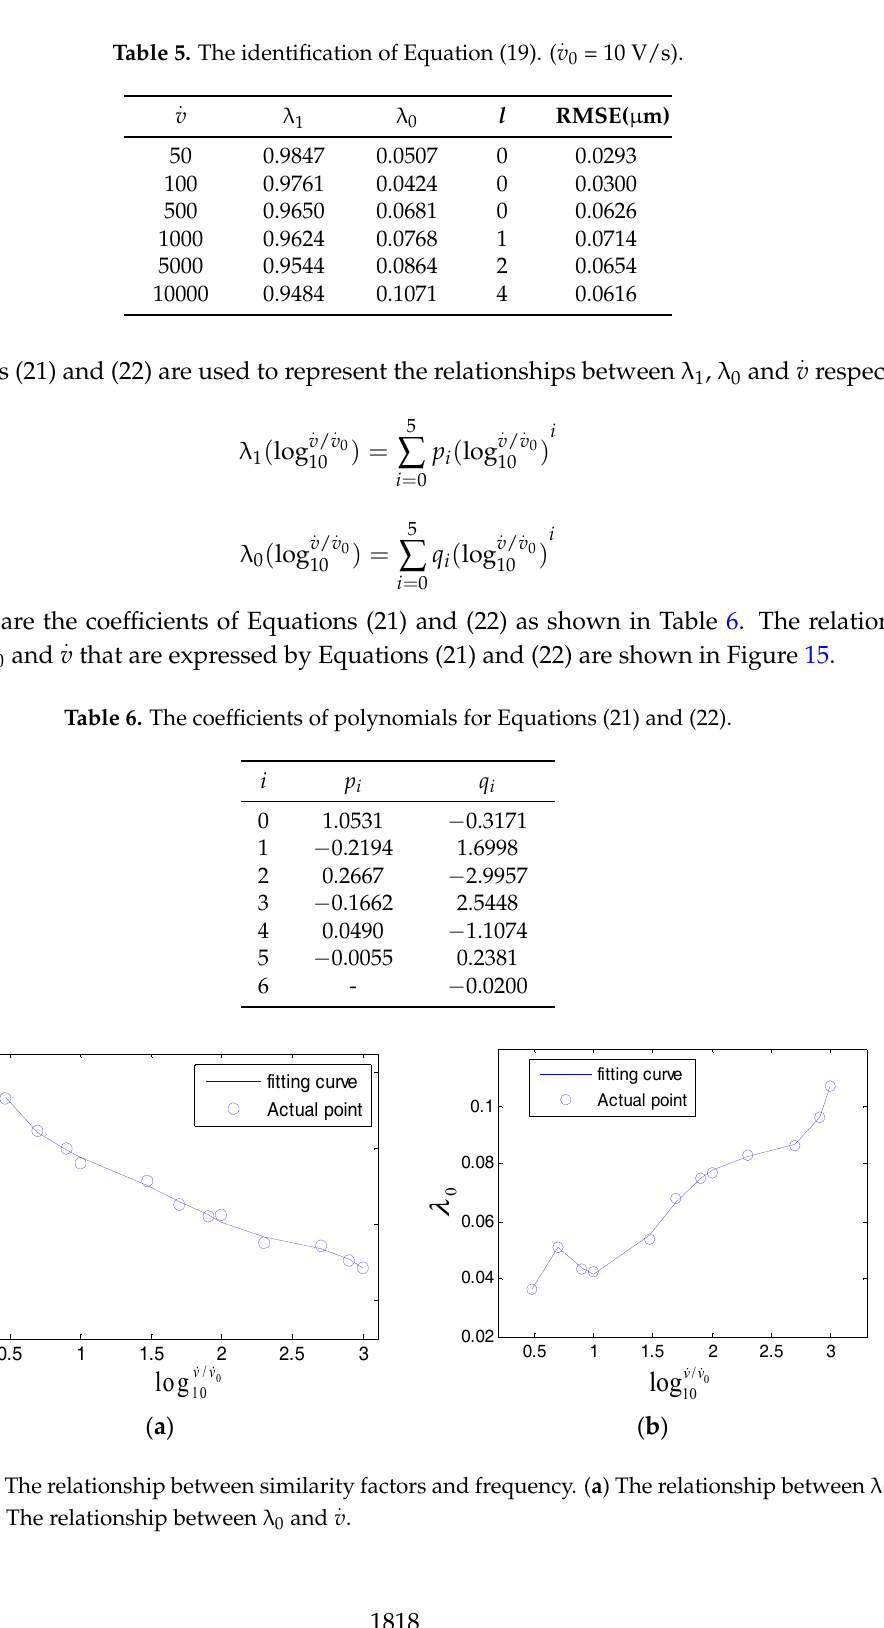
. (cid:1874) (cid:4662) . 0 and v